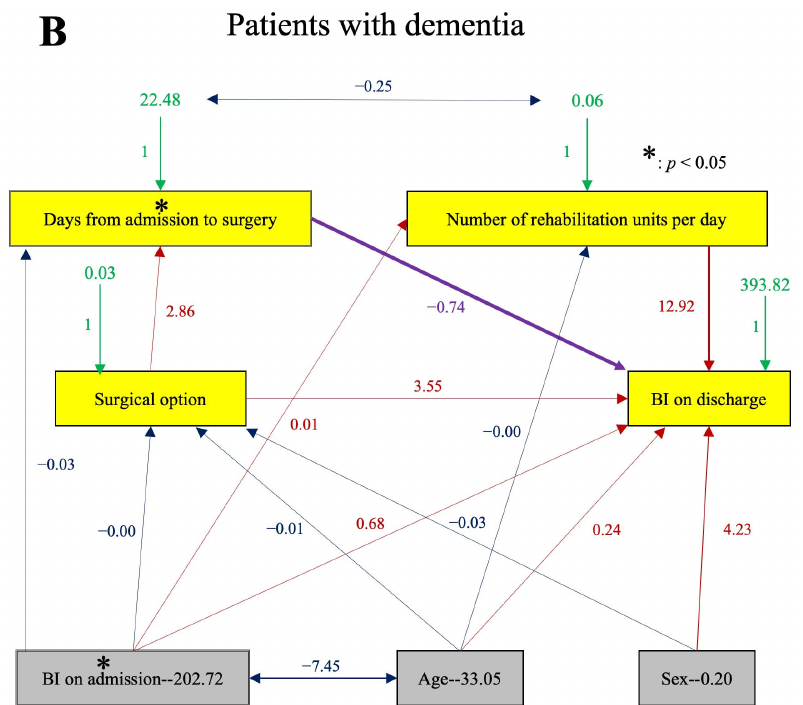
Figure 3. Simultaneous analysis of several groups. CFI, 0.98; GFI, 0.98; AGFI, 0.92; RMSEA, 0.05. The CFI, GFI, AGFI, and RMSEA indicate a good model fit. ( A ) Patients without dementia ( n = 136). ( B ) Patients with dementia ( n = 125). Red, positive correlation; blue, negative correlation; green, error variance; purple, equality constraint; line width, proportional to effect. CFI, comparative fit index; GFI, goodness ‐ of ‐ fit index; AGFI, adjusted goodness ‐ of ‐ fit index; RMSEA, root mean square error of approximation.